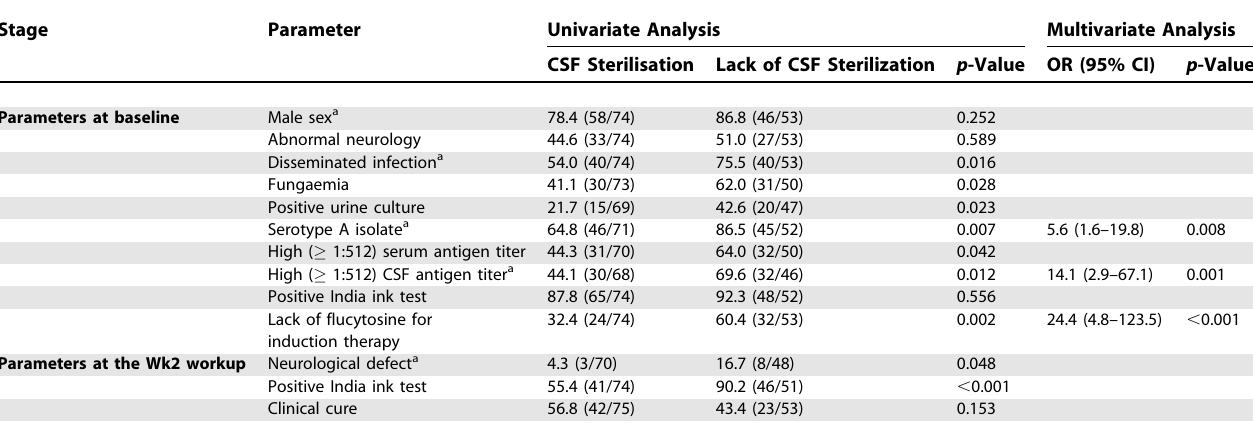
Table 5. Parameters Associated with Lack of CSF Sterilisation in 127 HIV-Positive Patients with Cryptococcal Meningoencephalitis: Univariate and Multivariate